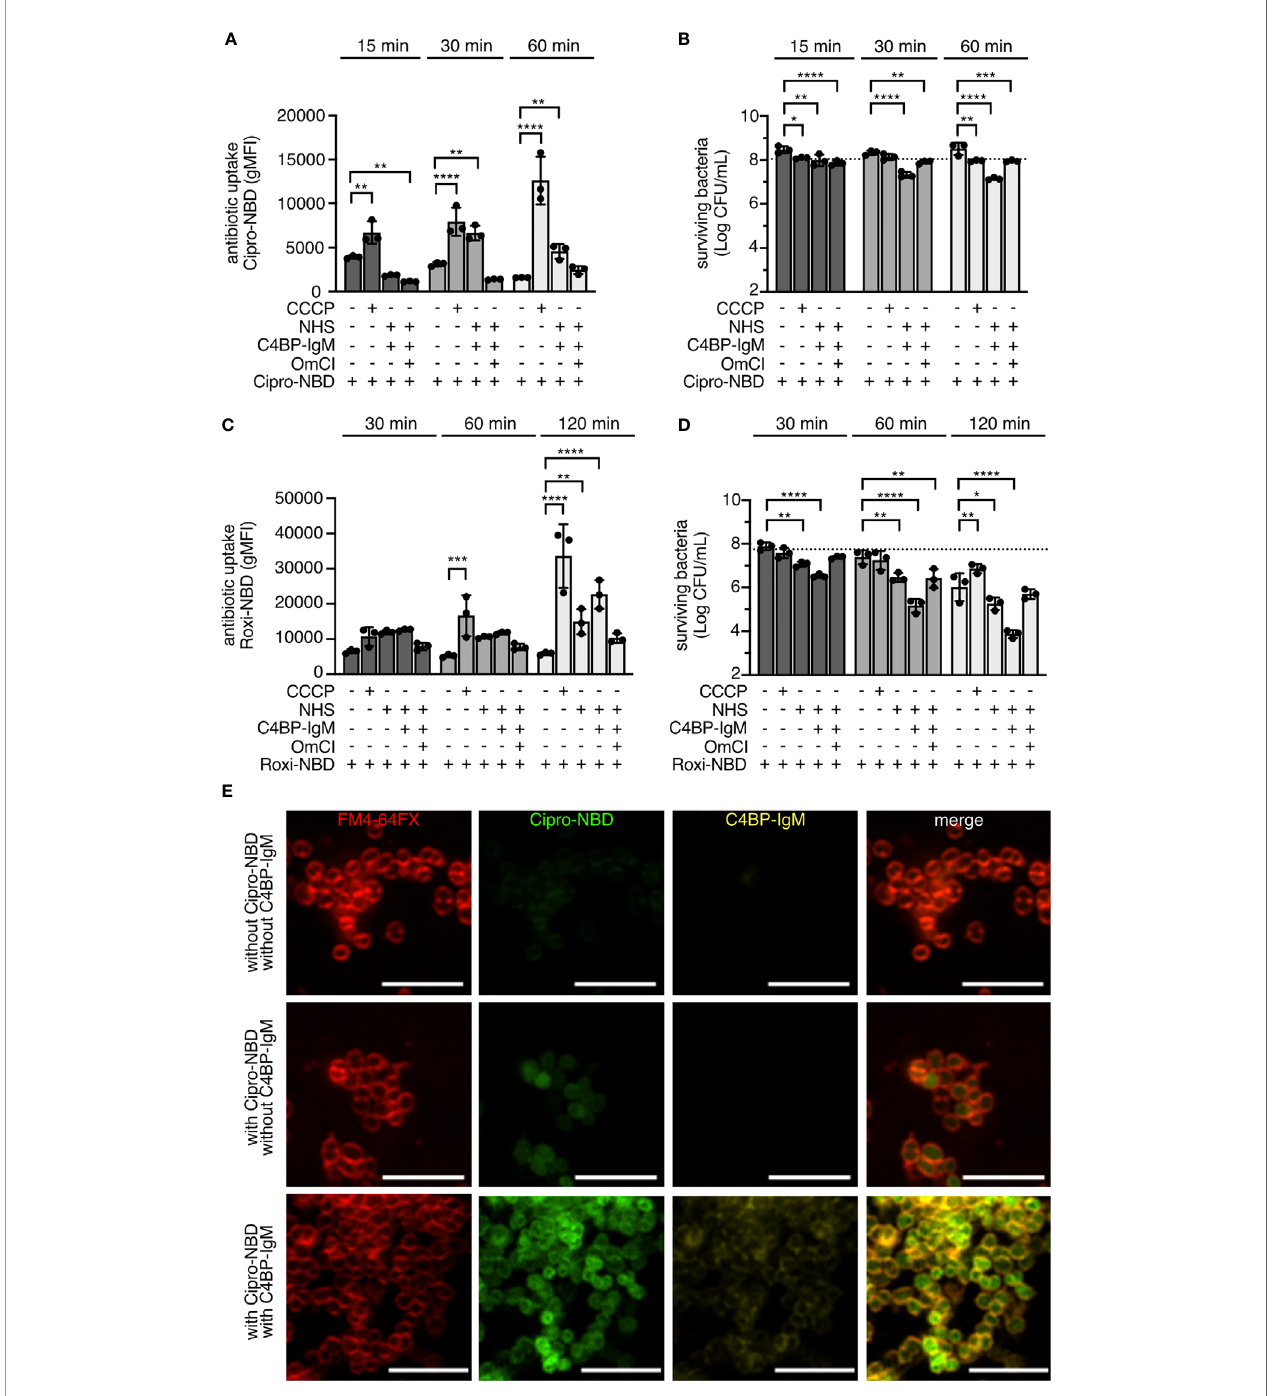
FIGURE 6 | NHS and C4BP-IgM promote internalization of antibiotics in N. gonorrhoeae FL29. FL29 gonococci were incubated with 20 m M of Cipro-NBD for 15, 30 and 60 min (A, B) or 20 m M of Roxi-NBD for 30, 60 and 120 min (C, D) at 37°C in the presence of 10% NHS+/-OmCI with or without 50 m M of CCCP or 1.25 m g/mL of C4BP-IgM. Internalized fl uorescent antibiotic is measured as fl uorescent signal (gMFI). Survival of bacteria is indicated as Log(CFU/mL), and horizontal dotted line indicates the average of Log(CFU/mL) of bacteria recovered in the absence of probes. Bars display mean+/-SD with circles indicating independent repeats; n = 3. Two-way ANOVA with Dunnett´s multiple comparison test was performed to analyze differences of samples in comparison to bacteria+probe. *p < 0.05, **p < 0.01, ***p < 0.005, ****p < 0.0001. (E) Airyscan confocal fl uorescent microscopy of live FL29 labeled with FM4-64FX membrane dye and treated with or without 20 m M of Cipro-NBD for 30 min at 37°C in the presence or in the absence of NHS and C4BP-IgM, the latter detected using an Alexa Fluor-647 labeled anti- human IgM. Scale bar: 5 m